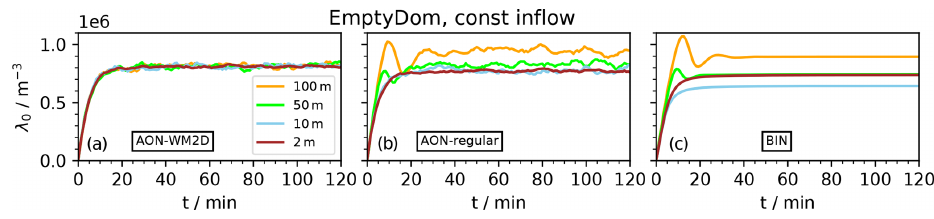
Figure 14. EmptyDom set-up: temporal evolution of column-averaged moments λ 0 and λ 2 for various model versions (AON-WM2D, a ; AON-WM3D, b ; BIN, c ). Each panel shows a variation of the vertical resolution (cid:49)z (see legend in the left panel). In LCM simulations, SIP numbers for (cid:49)z = 100 and 50m simulations are increased to the level of the (cid:49)z = 10m